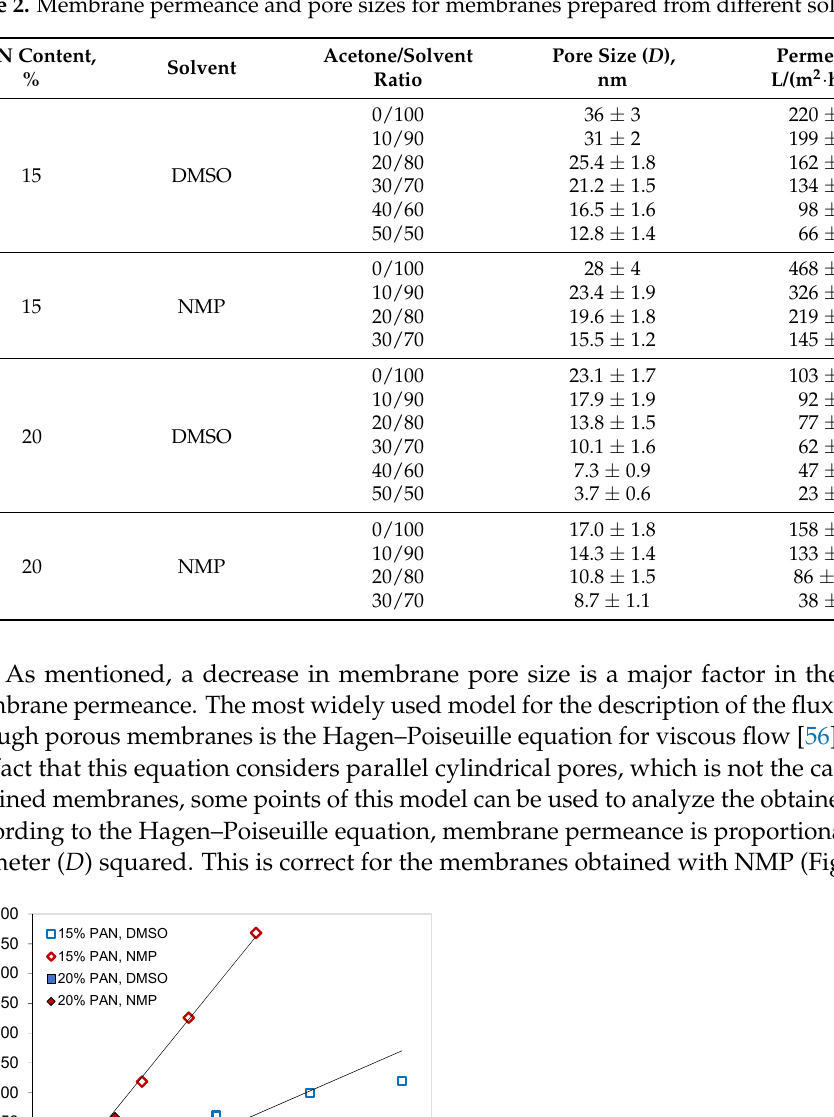
Table 2. Membrane permeance and pore sizes for membranes prepared from different solutions.